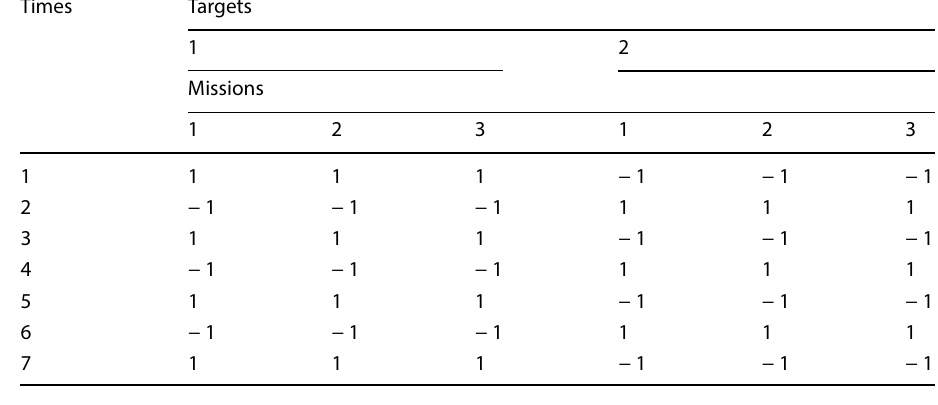
Table 3 Scheduling the activation of a sensor i for each face f of a mission m